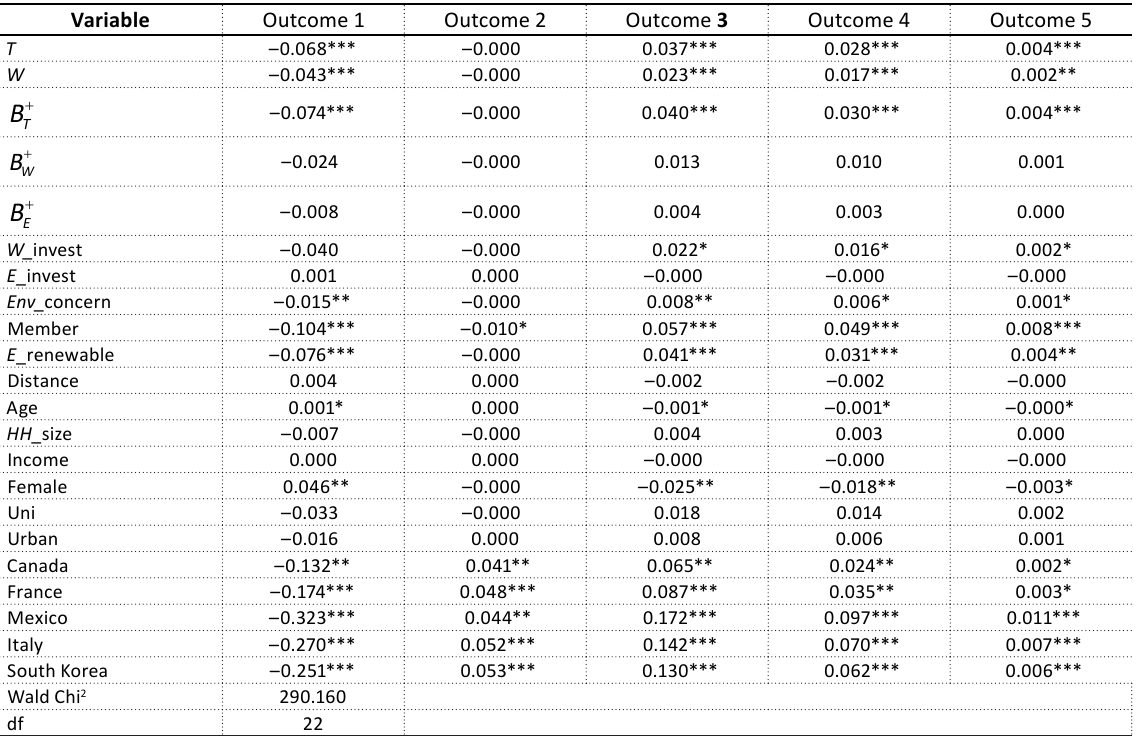
Table B3. Average discrete effects of ordered probit, dependent variable: ordinal responses for WTP for pro-environmental goods, base good: renewable-energv-only